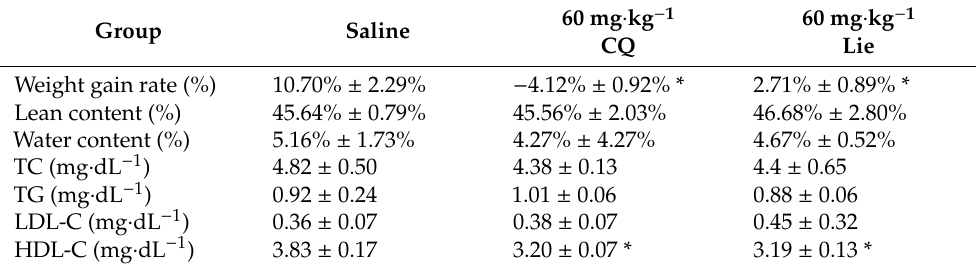
Table 1. Metabolic characteristics of study mice treated with HFD + 60 mg kg − 1 CQ, HFD + 60 mg kg − 1 Lie or HFD + saline for 15 days after β 3-AR agonist